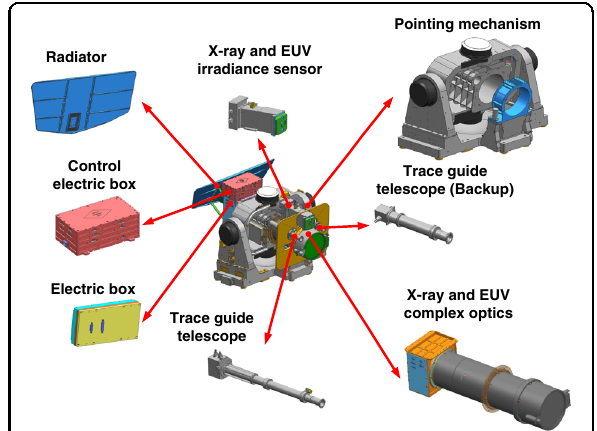
Fig. 9 X-EUVI instrument and its composition